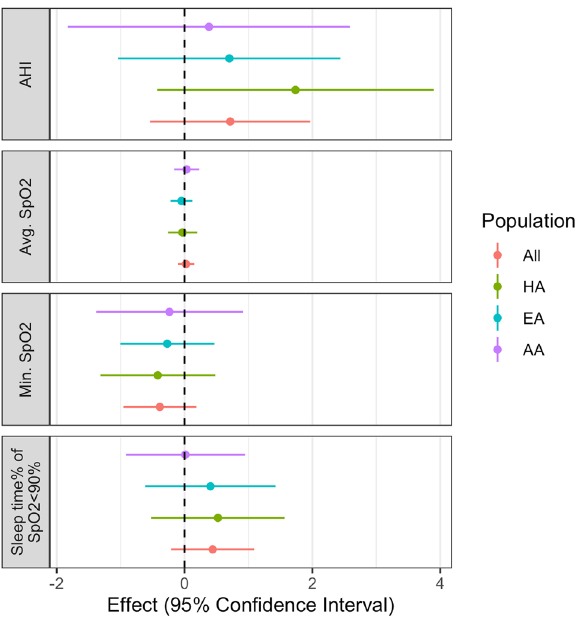
Figure 4. Validation MR analysis of the effect of upregulated Heme Biosynthetic Process pathway on OSA traits in